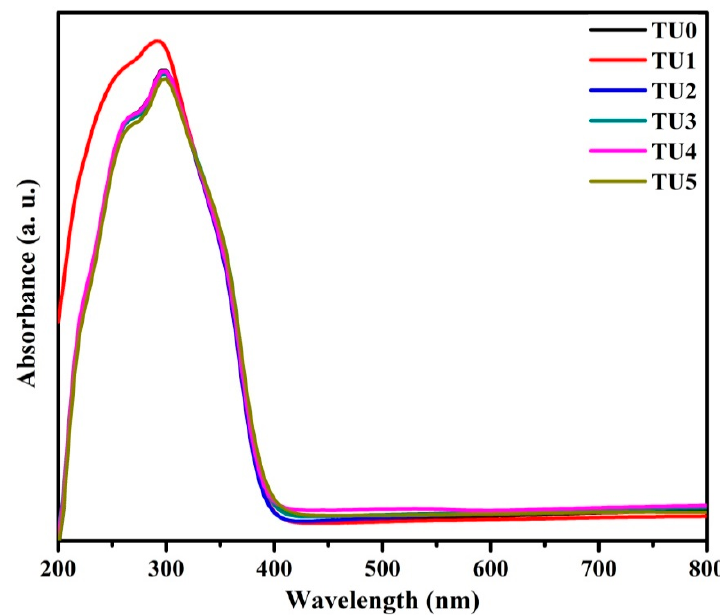
Figure 5. UV–Vis diffuse reflectance spectra of TU0, TU1, TU2, TU3, TU4 and TU5.